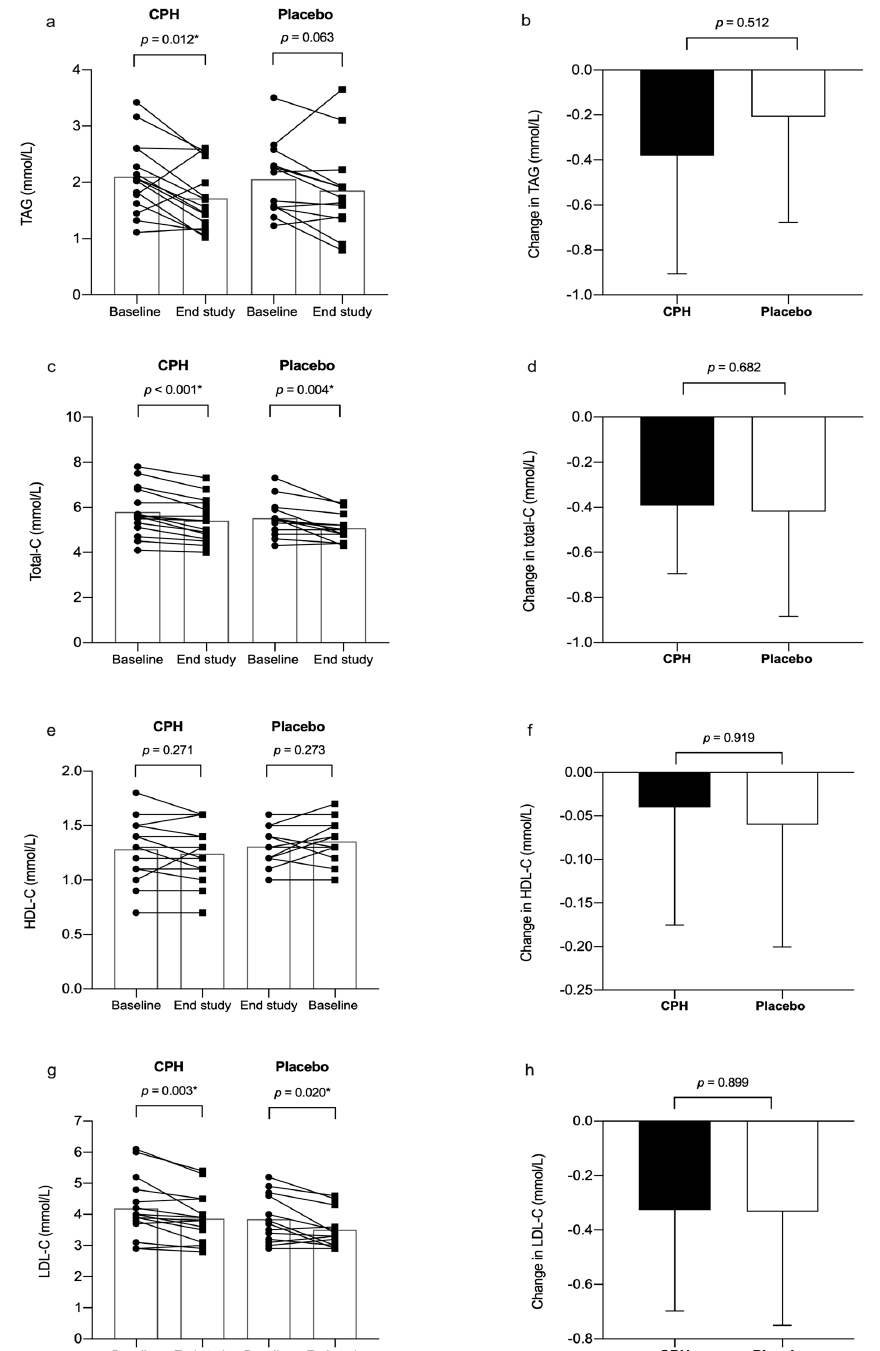
Figure 3. Fasting and change in serum levels of triacylglycerol (TAG) ( a , b ), total cholesterol (total-C) ( c , d ), high-density lipoprotein cholesterol (HDL-C) ( e , f ) and low-density lipoprotein cholesterol (LDL-C) ( g , h ) in subjects with MetS after 8 weeks intervention with cod protein hydrolysate (CPH) ( n = 15) or placebo ( n = 13). Two subjects from the placebo group were excluded from the statistical analyses of lipid parameter due to the use of lipid-lowering drugs. A ( c , e , g ), results are presented as individual graphs with fasting levels at baseline and end of study for each subject, with bars showing the mean in each group. p -values were calculated from a paired samples t -test. B ( d , f , h ), changes were calculated as individual end of study values minus baseline values for each of the indicators. Results are presented as the mean di ff erence. p -values were calculated using the independent samples t -test. Significant p -values are marked with asterisk